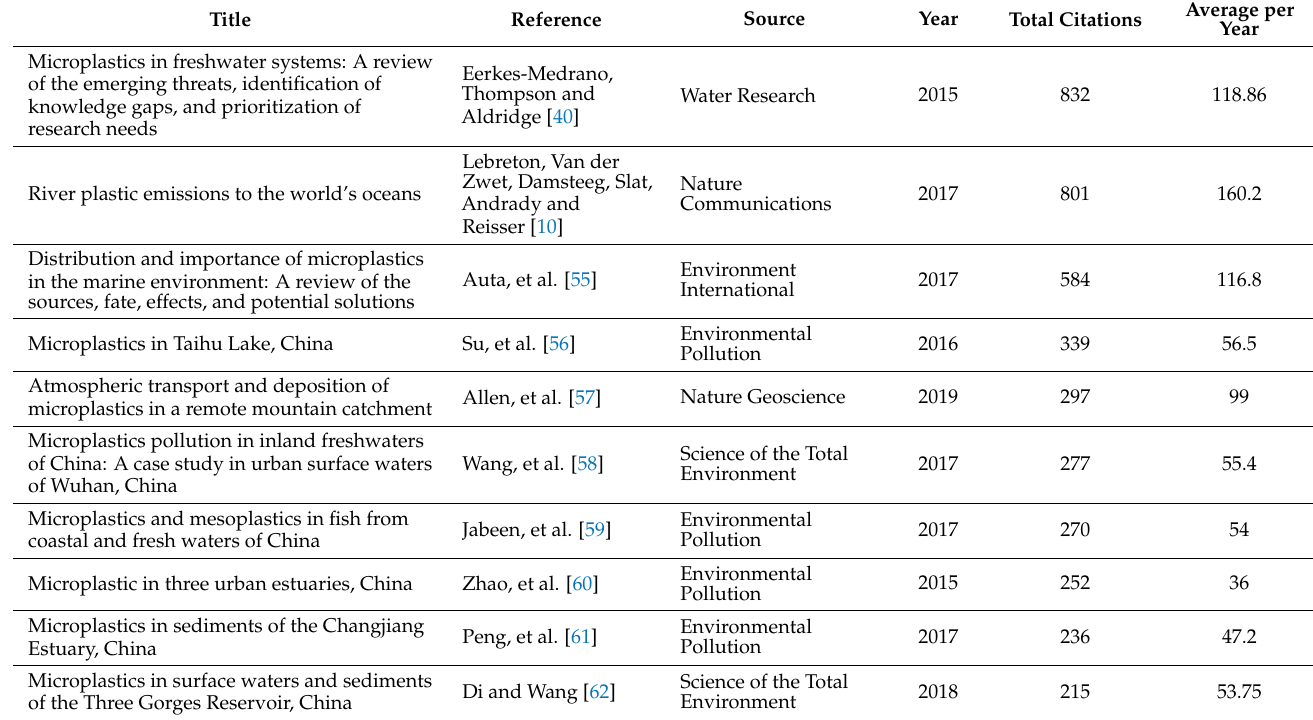
Table 3. The top 10 most cited